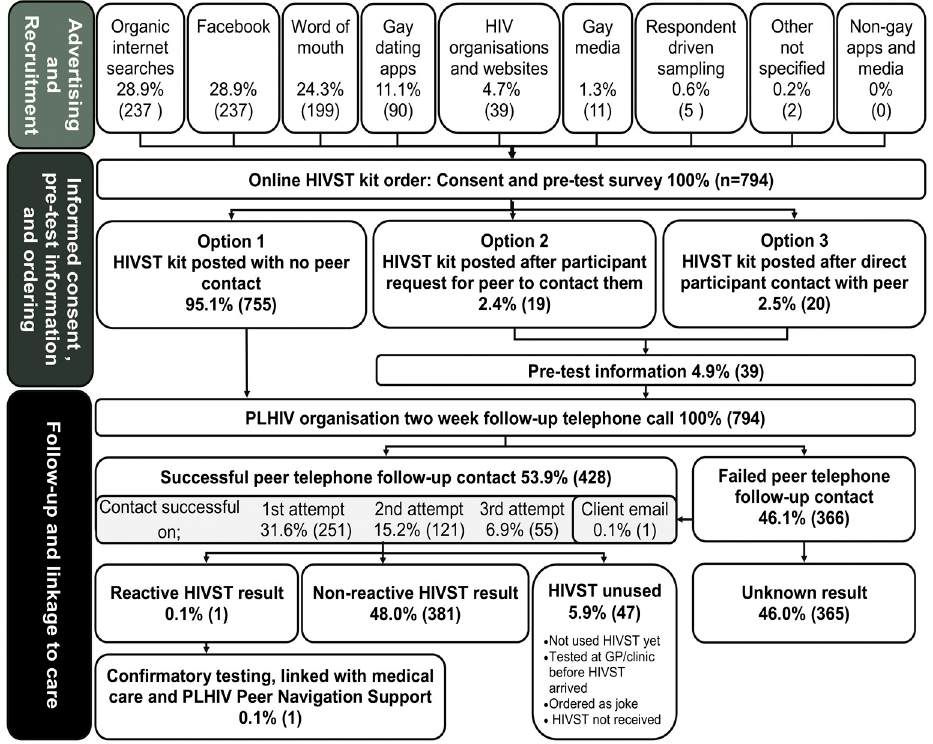
Figure 1. Schematic representation of the HIV self-testing study flow and outcomes of the first ordered HIVST kits ( n = 794).